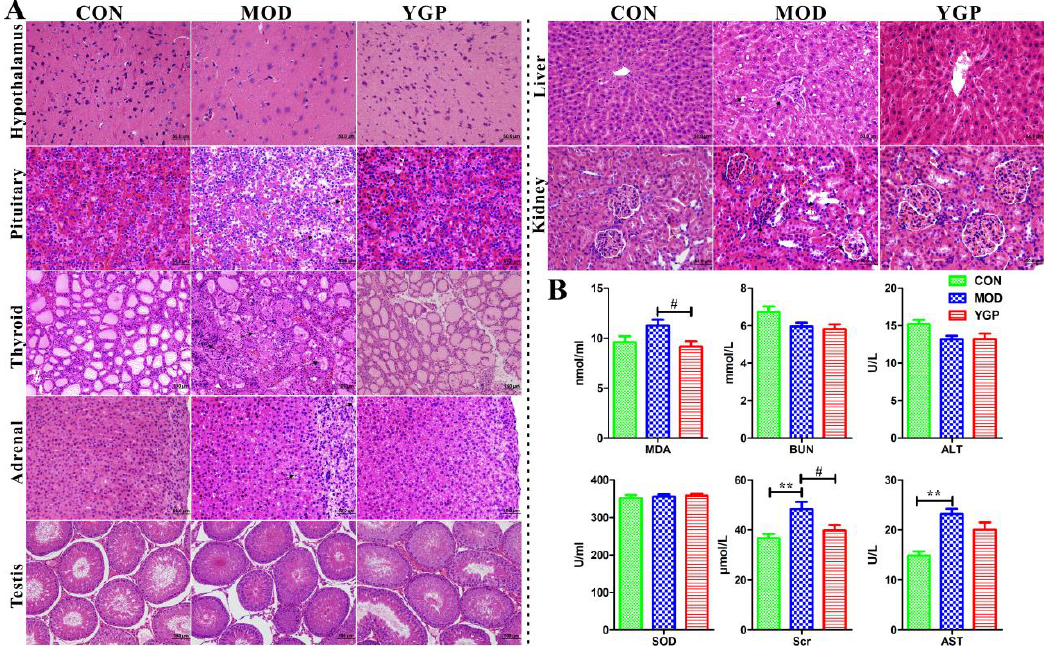
Figure 1. Typical histopathological changes of hypothalamic-pituitary-target gland axis ( A ), and the changes of biochemical indexes related to oxidative stress, and function of the liver and kidney ( B ). The magnification of hypothalamus, pituitary, adrenal gland, liver and kidney is 40×, while the magnification of thyroid and testis is 20×. * as compared with the control group (CON), * p < 0.05, ** p < 0.01, # as compared with the KYDS group (MOD), # p < 0.05, ## p < 0.01.